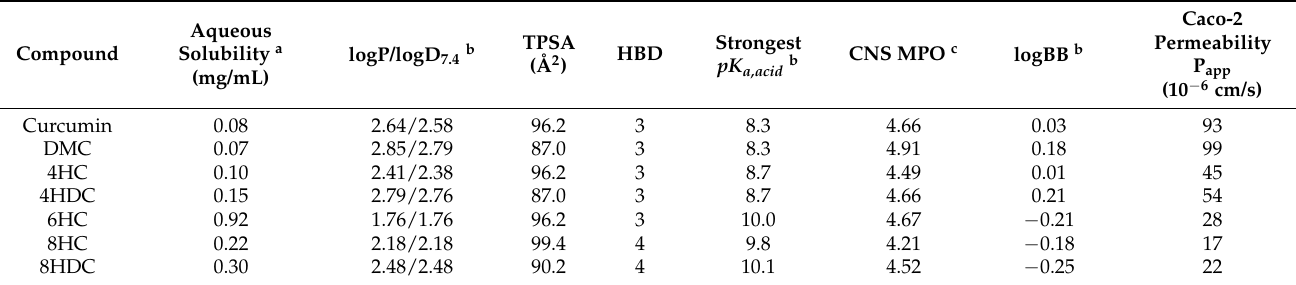
Table 3. Predicted physicochemical and ADME properties of curcumin and hydrocurcumin analogues (using ACD/Labs Percepta software [42]). P app : apparent permeability. HBD: number of hydrogen bond donors. CNS MPO: Central Nervous System Multiparameter Optimization introduced by Wager et al. [43].